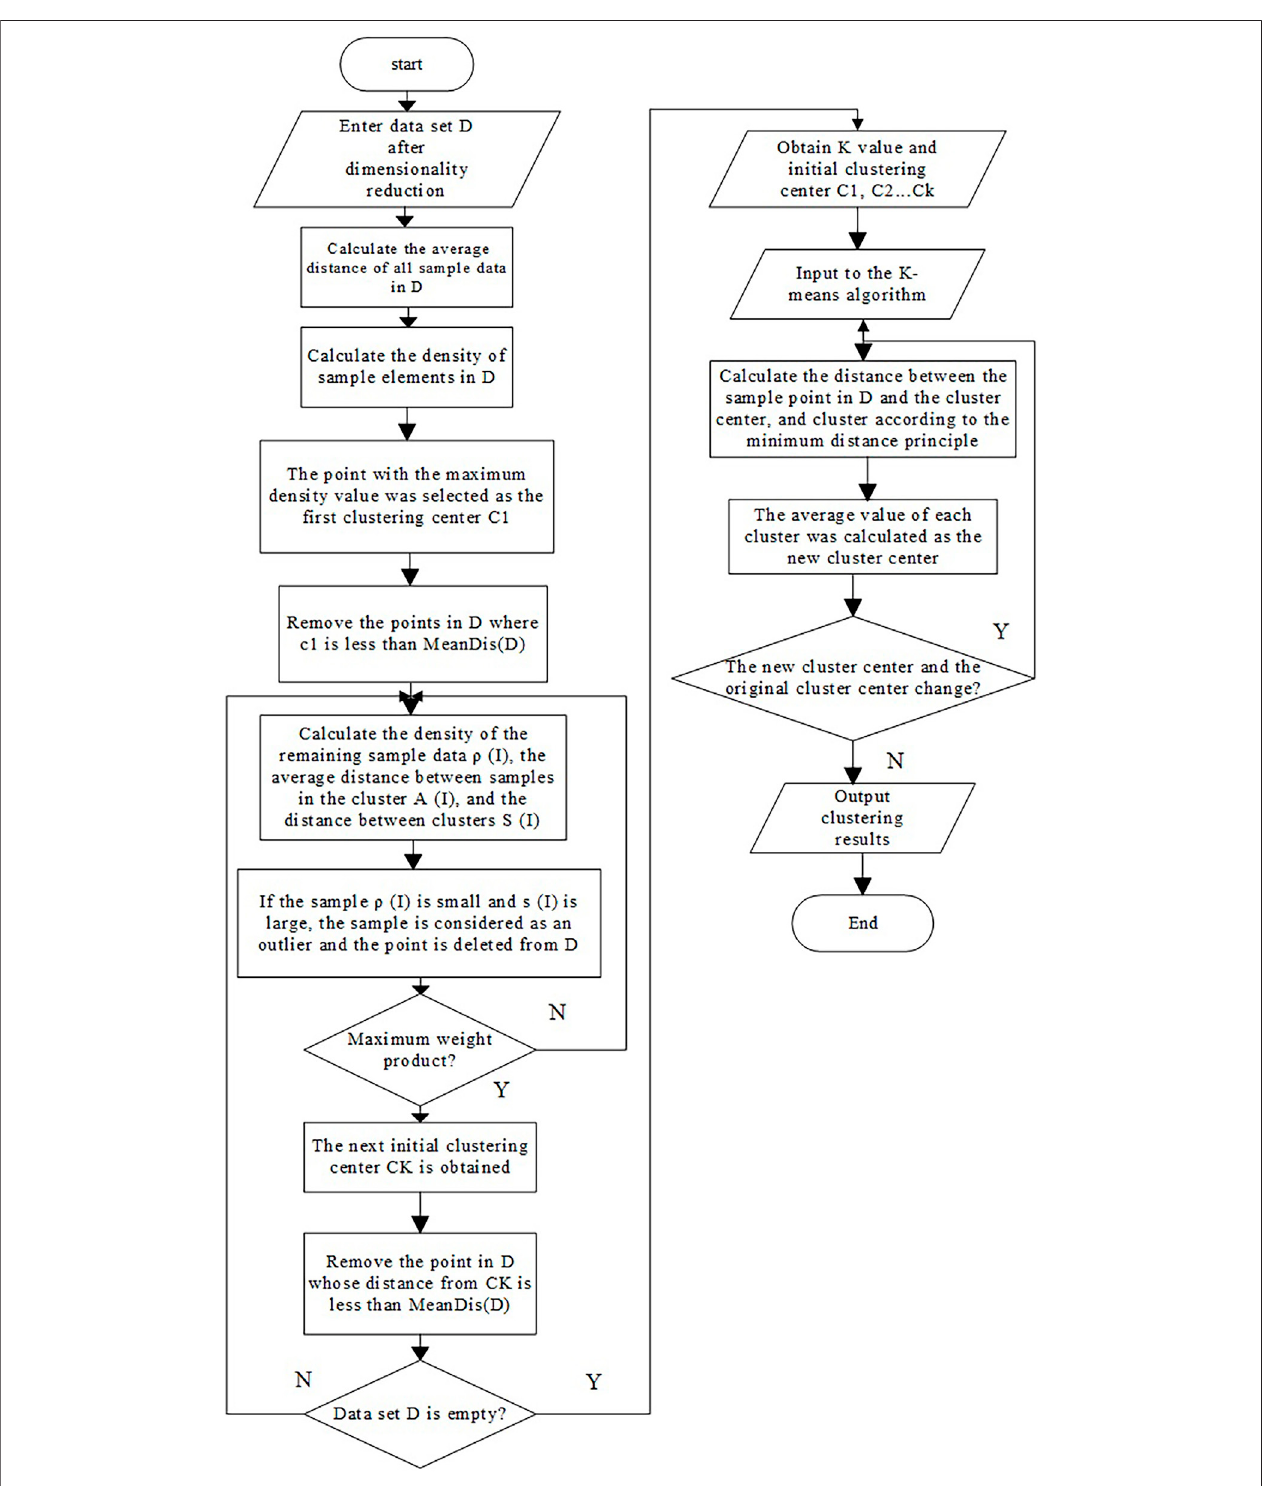
FIGURE 2 | Flow chart of improved K-means algorithm.